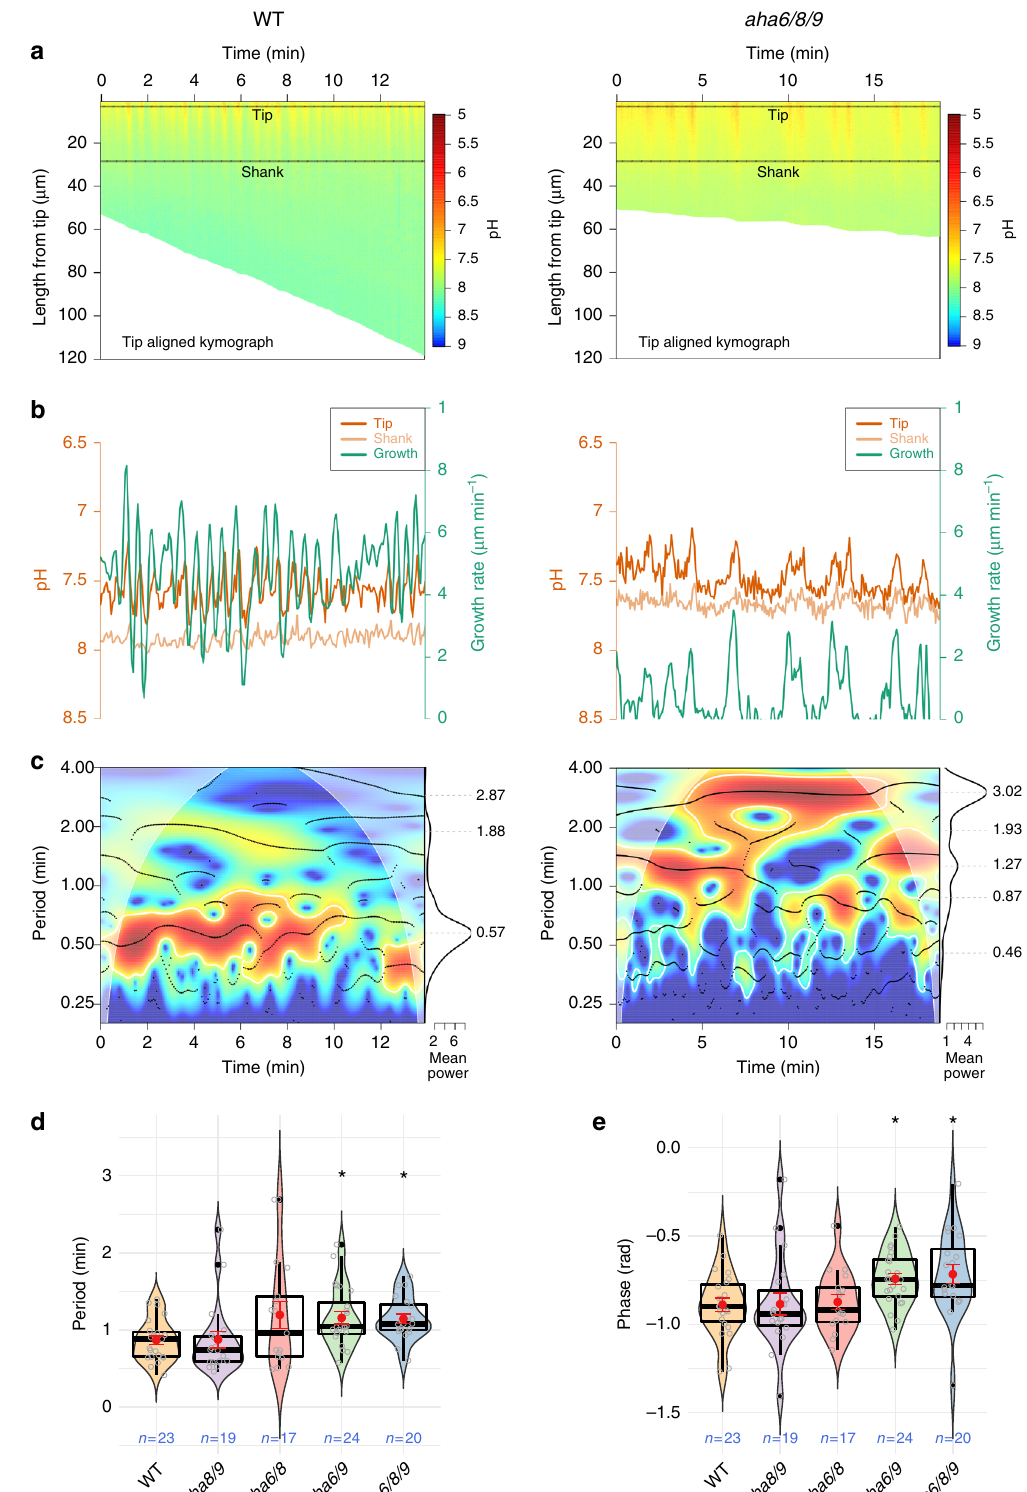
plant cell phenotyping. We focused on the sub-apical zone membrane potential has previously been determined to be at – 127 mV 61 . As the linearity of the ANNINE6-plus response at (10 – 20 µm distal from the tip, where AHA labeling fades away) such negative values has not been determined, one cannot and the AHA-stabilized shank (40 – 50 µm from the tip) (Sup- extrapolate exact values for the mutant, but given the linearity of plementary Fig.12 a – e). From this analysis, it was evident that the the dye response over 120 mV (reviewed in ref. 58 ), values more aha6/8/9 mutants had less hyperpolarized membrane potentials positive than – 70 mV should be expected for the triple mutant. than the wild-type, (<50% fl uorescence) (Fig. 6d). The wild-type NATURE COMMUNICATIONS|